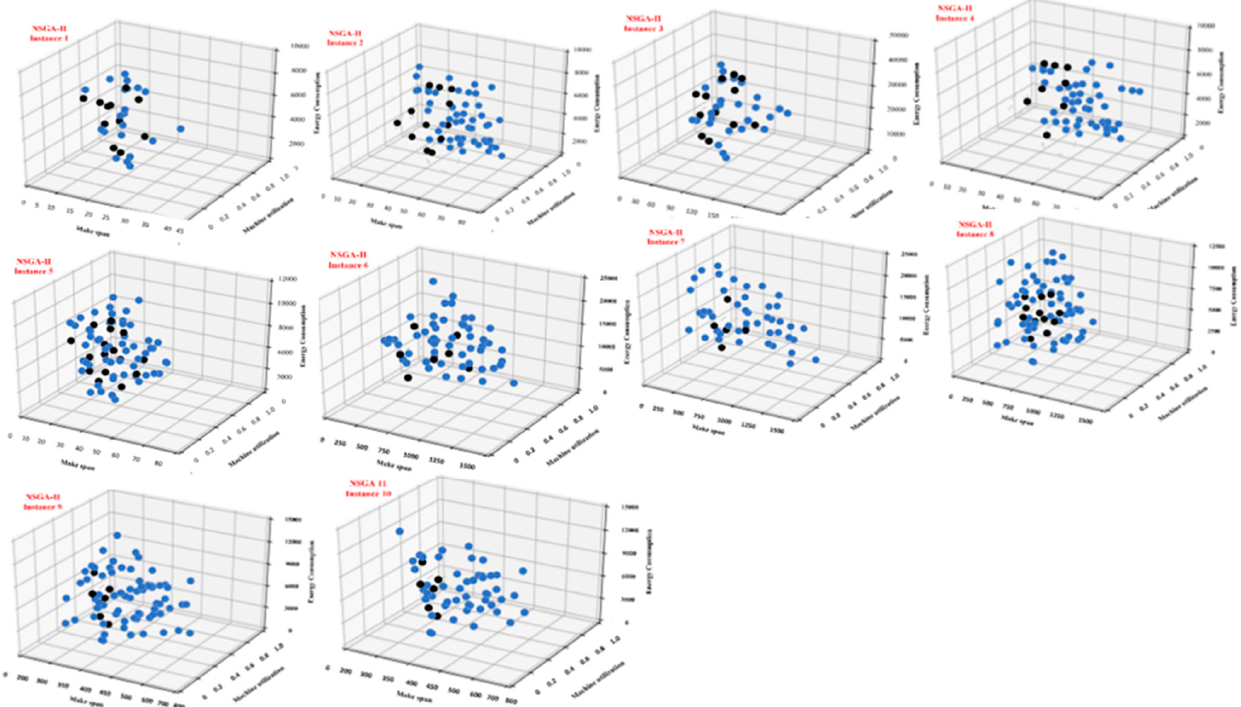
Figure 17. Pareto optimal graphs showing various solutions for three objectives makespan, energy consumption, and Machine utilization for NSGA-II algorithm.